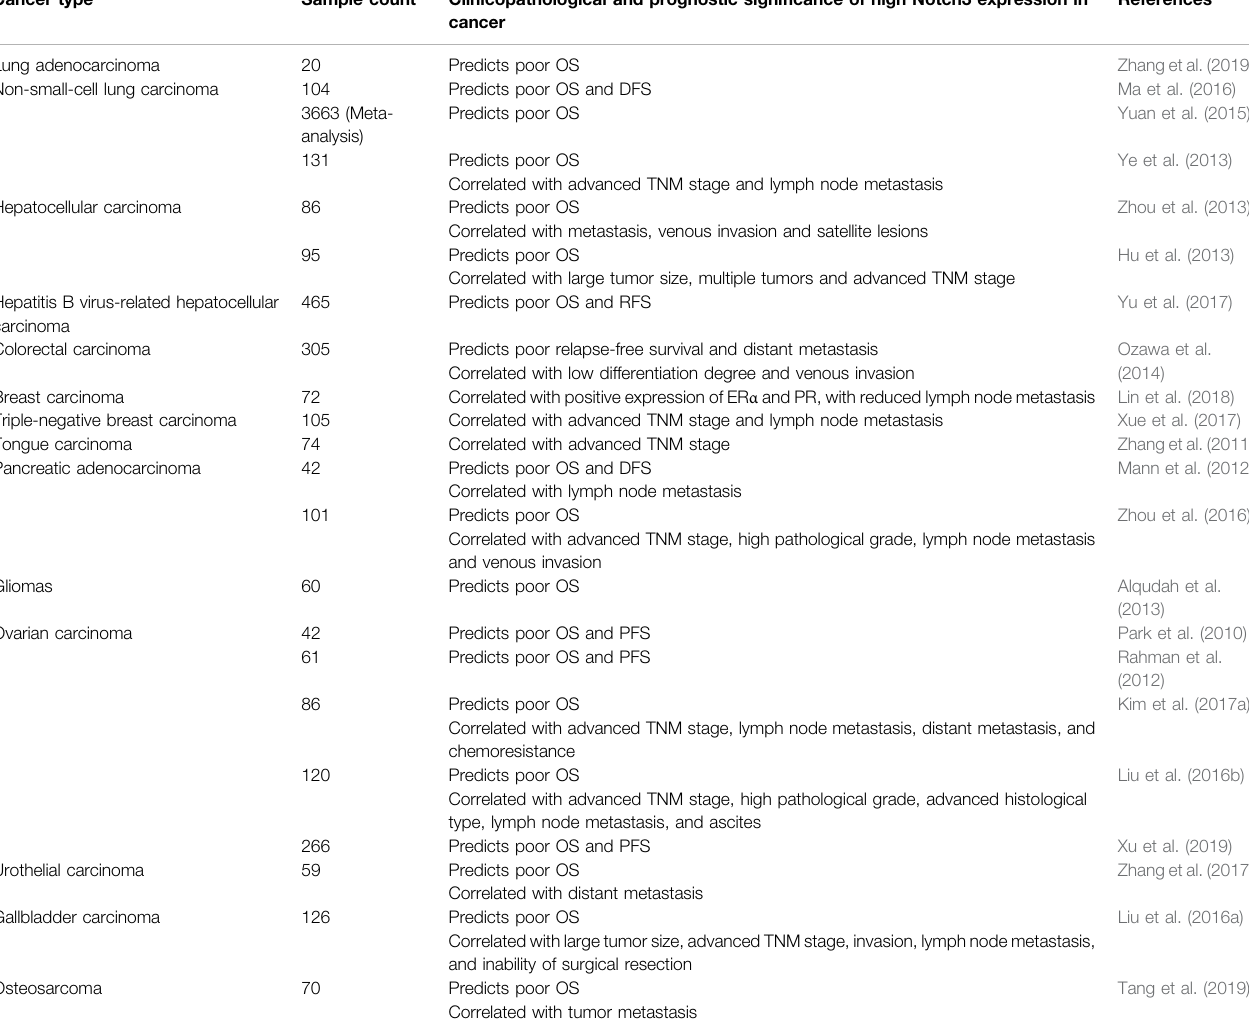
TABLE 1 | The clinical signi fi cance of Notch3 in different types of cancer. Cancer